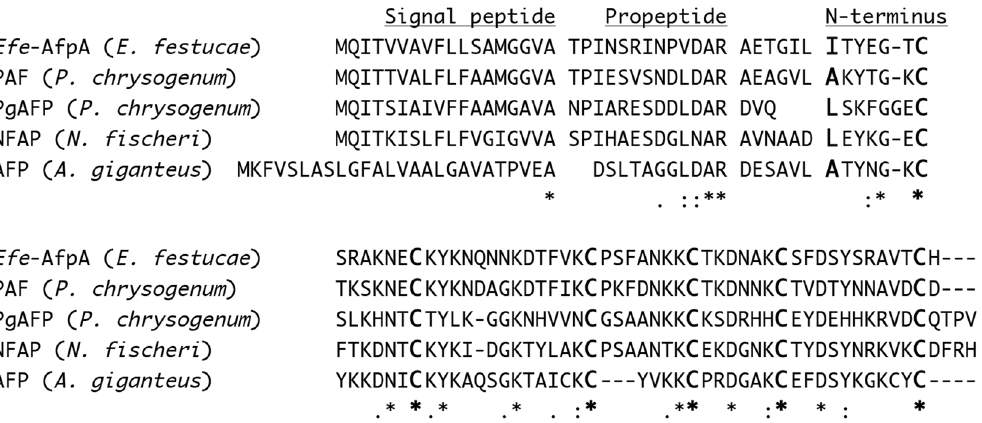
Figure 2. Amino acid alignment of Efe -AfpA from E . festucae (accession SRR493691.12929) with PAF from P . chrysogenum (accession U22944.2), PgAFP from P . chrysogenum (accession D0EXD3.1), NFAP from N . fischeri (accession AM983570), and AFP from A . giganteus (accession X60771). The experimentally determined N-terminus of each protein is in bold larger font size. The conserved cysteines are also in bold larger font size. Breaks in the sequences were introduced to indicate the predicted signal peptide cleavage sites, the proposed propeptide cleavage sites, and the proposed final processing sites. An asterisk indicates identical residues in all sequences, a “:” indicates strongly conserved residues (score > 0.5), and a “.” indicates weaker conserved residues (score < 0.5) 65